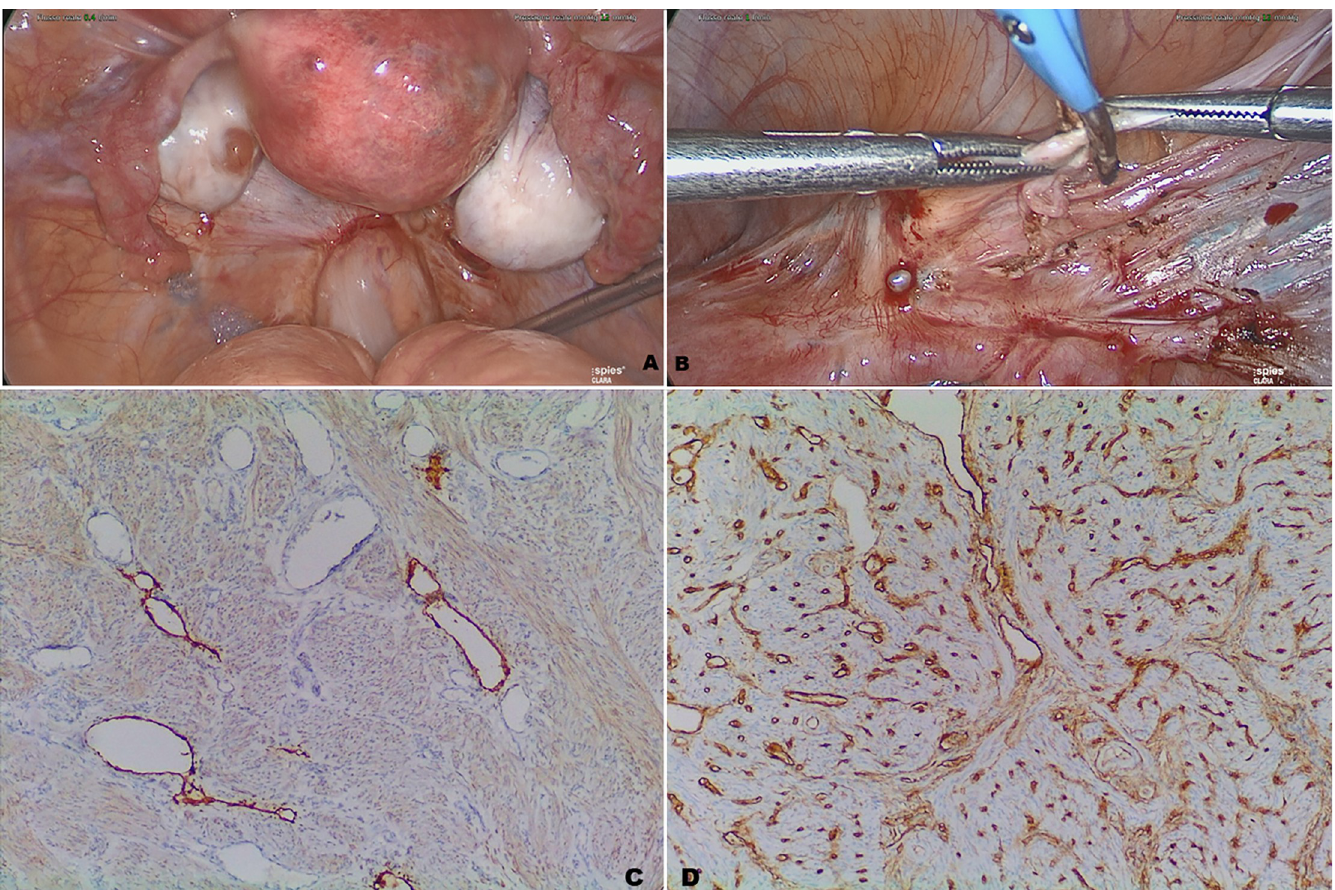
Fig 4. Laparoscopic and histologic images. Clustered areas of the uterus were permeated by the methylene blue during a dye test that showed bilateral permeability of the tubes (A). After opening the peritoneum of the anterior broad ligament, a blue staining of the connective tissue beneath the round ligament ( � ) was found (B). In this case, a deep biopsy of the uterine wall where the color changed was taken and adenomyosis with ectatic lymphatic vessels was demonstrated. Deparaffinized 4- μ m sections were immunostained with antibodies against CD34 and podoplanin (C and D, respectively) to confirm that the ectatic vessels were lymphatics.